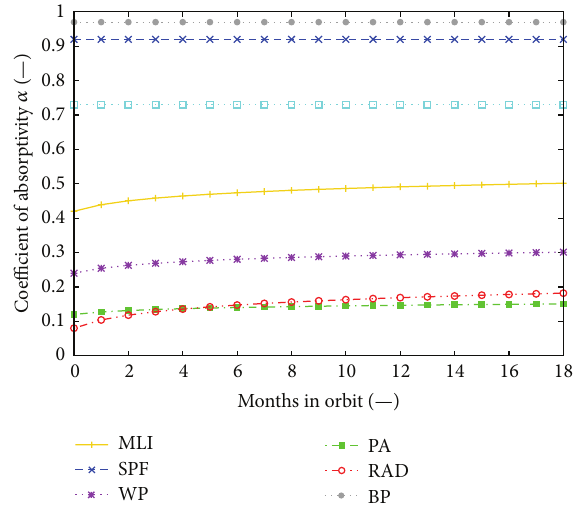
Figure 12: Considered variation of solar absorptivity over mission lifetime of 18 months for chosen external components of MICRO- SCOPE test case. MLI: Multilayer Insulation, SPF: Solar Panel Front, WP: White Paint, KV: Kevlar, PA: Polished Aluminum, RAD: Radiator surface, and BP: Black